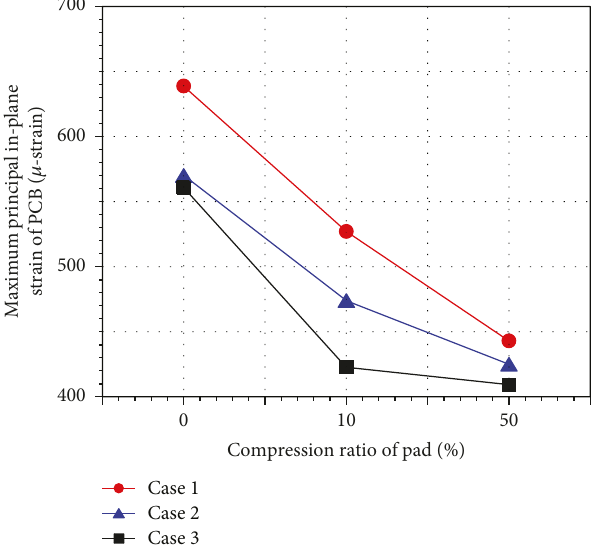
Figure 15: Maximum principal in-plane strain of PCB in accordance with compression ratio of the thermal gap pad in each case.